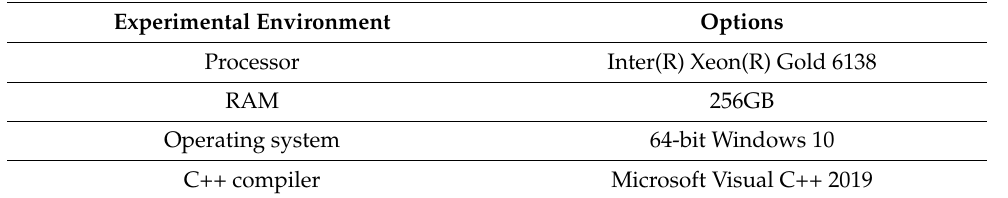
Table 3. Experimental